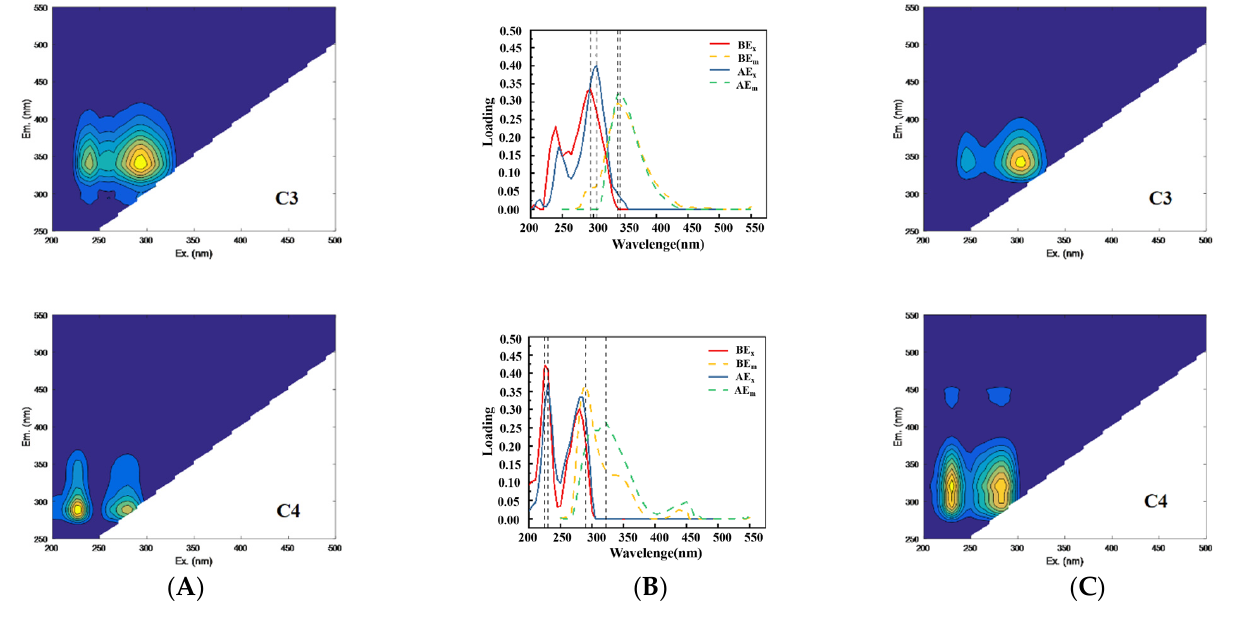
Figure 5. Output and verification results of the PARAFAC model of the DOM component fluores- cence spectrogram: ( A ) before degradation; ( B ) fluorescence loading; and ( C ) after degradation. ( A , C ): PARAFAC model output for fluorescent components: C1, short-wavelength fulvic-like sub- stances (terrestrial humic-like fluorescence peak A); C2, short-wavelength tryptophan-like substances (protein-like fluorescence peak T2); C3, tryptophan-like substances (protein-like fluorescence peak T1); and C4, tyrosine-like substances (protein-like fluorescence peak B1). ( B ): Load verification results corresponding to the components; left peak: excitation wavelength load, right peak: emission wavelength load.